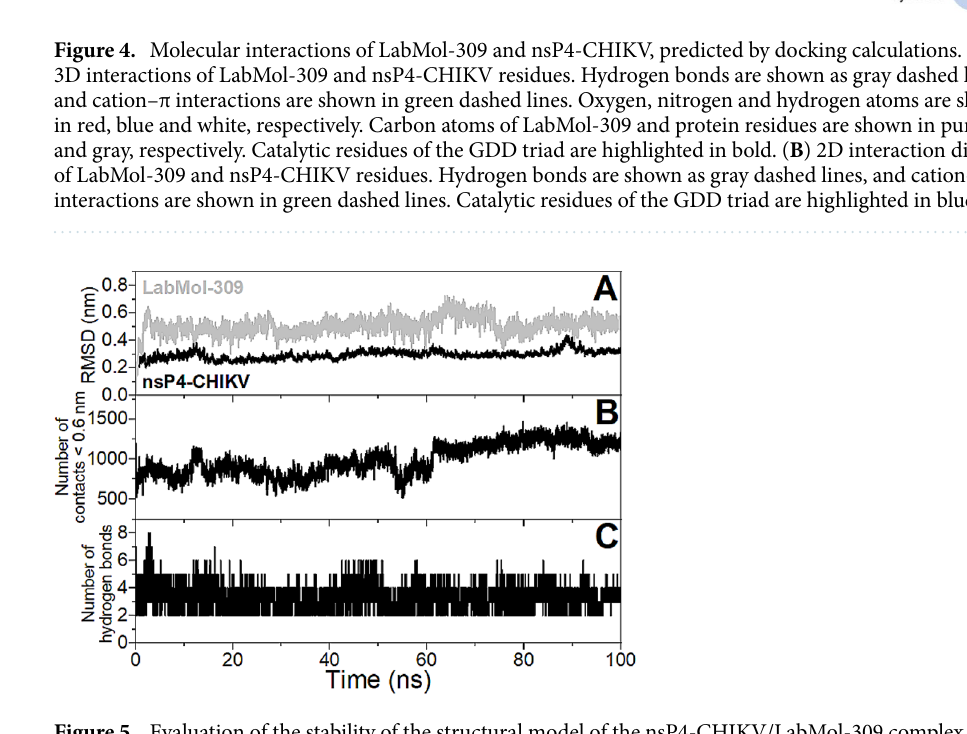
Figure 5. Evaluation of the stability of the structural model of the nsP4-CHIKV/LabMol-309 complex from 100 ns MD simulation. ( A ) RMSDs of backbone atoms of the protein (black line) and non-hydrogen atoms of the ligand (gray line). ( B ) Number of contacts between atoms of the protein and ligand for distances less than 0.6 nm. ( C ) Number of hydrogen bonds formed between the protein and